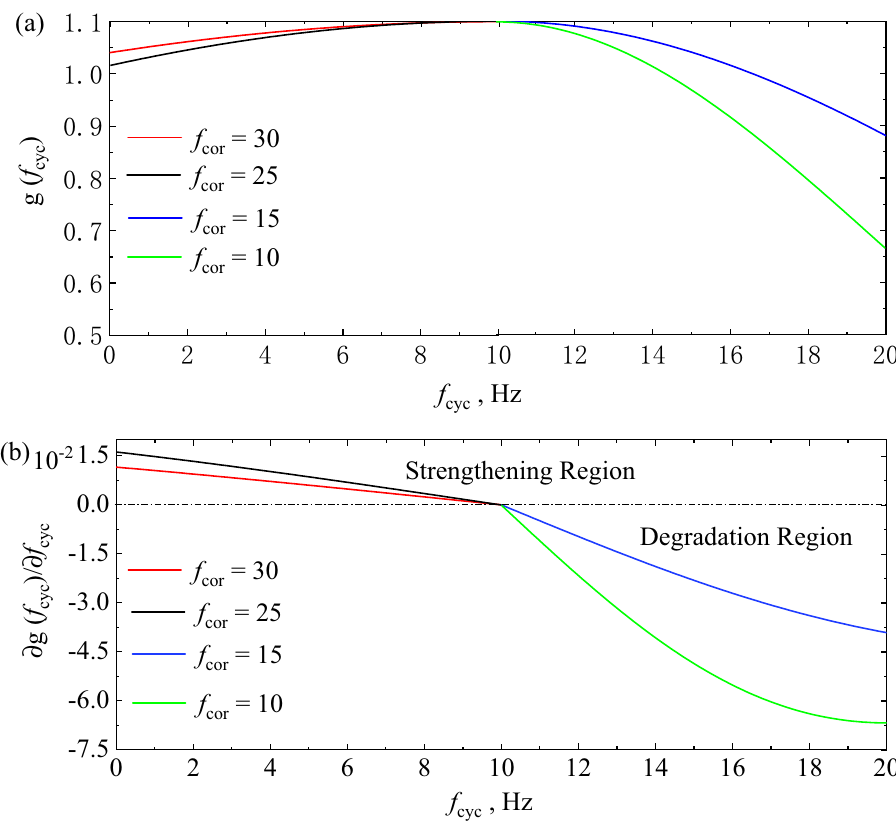
Figure 12. Cyclic loading frequency correction function, ( a ) focusing on f cyc and ( b ) enhancement and degradation degree of M r effected by f cyc